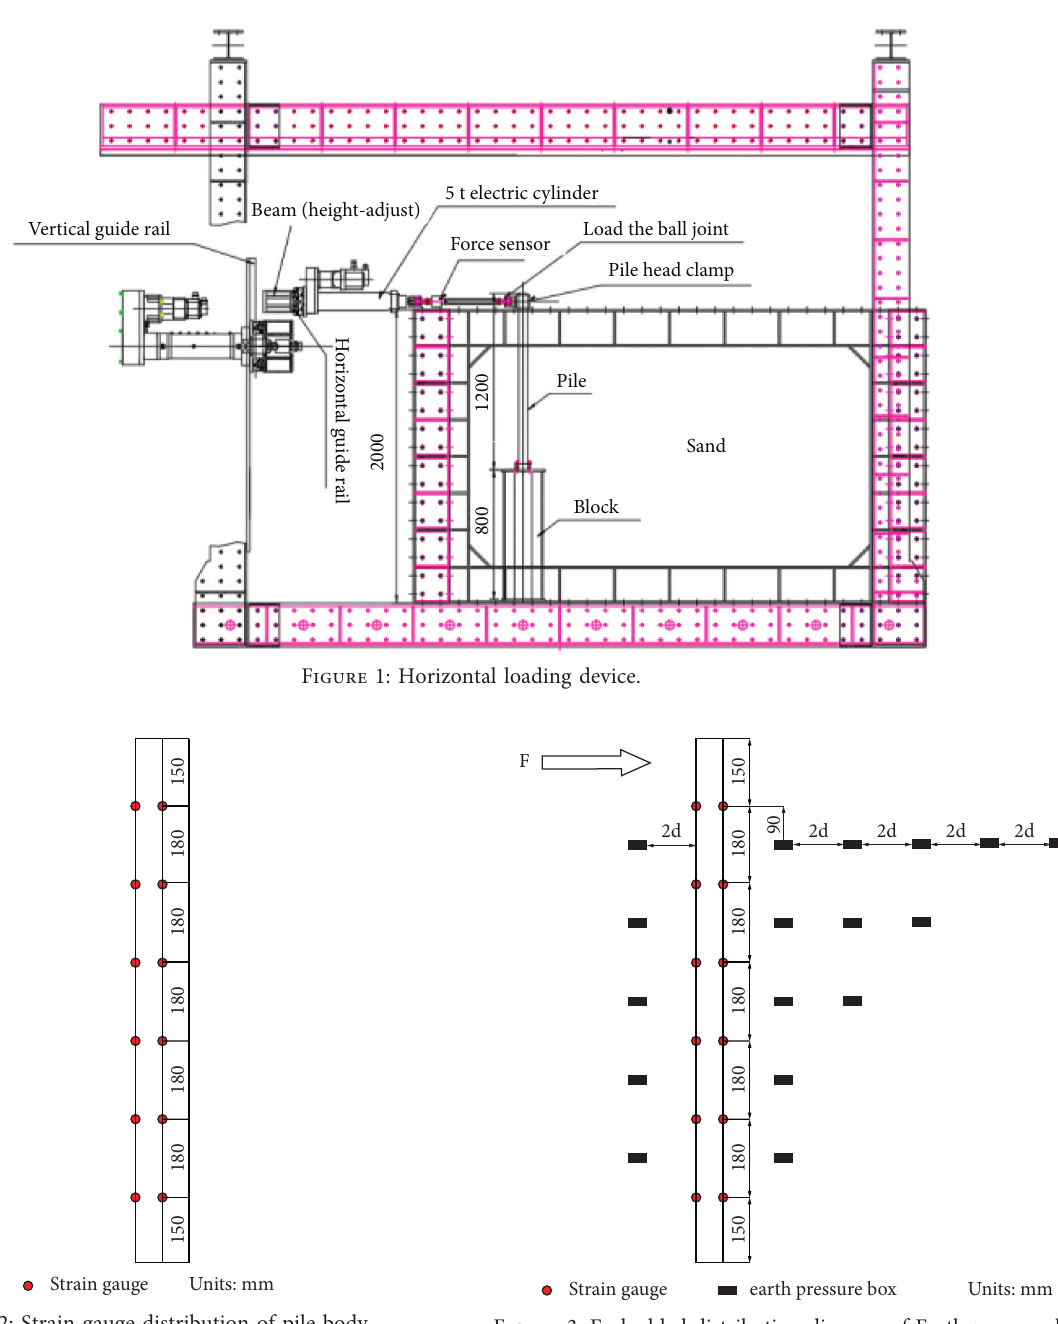
3: Embedded distribution diagram of Earth pressure